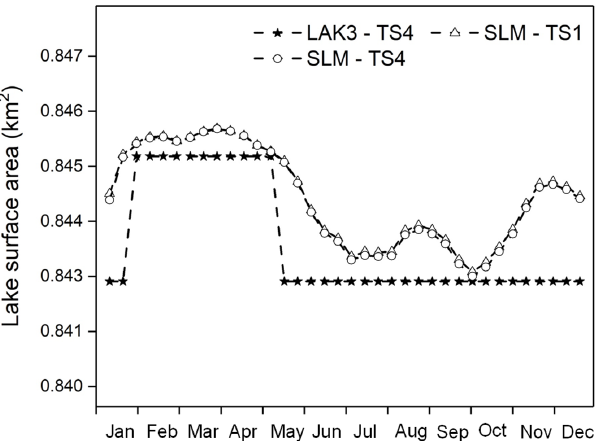
Figure 8. Simulated lake surface area in 2008.